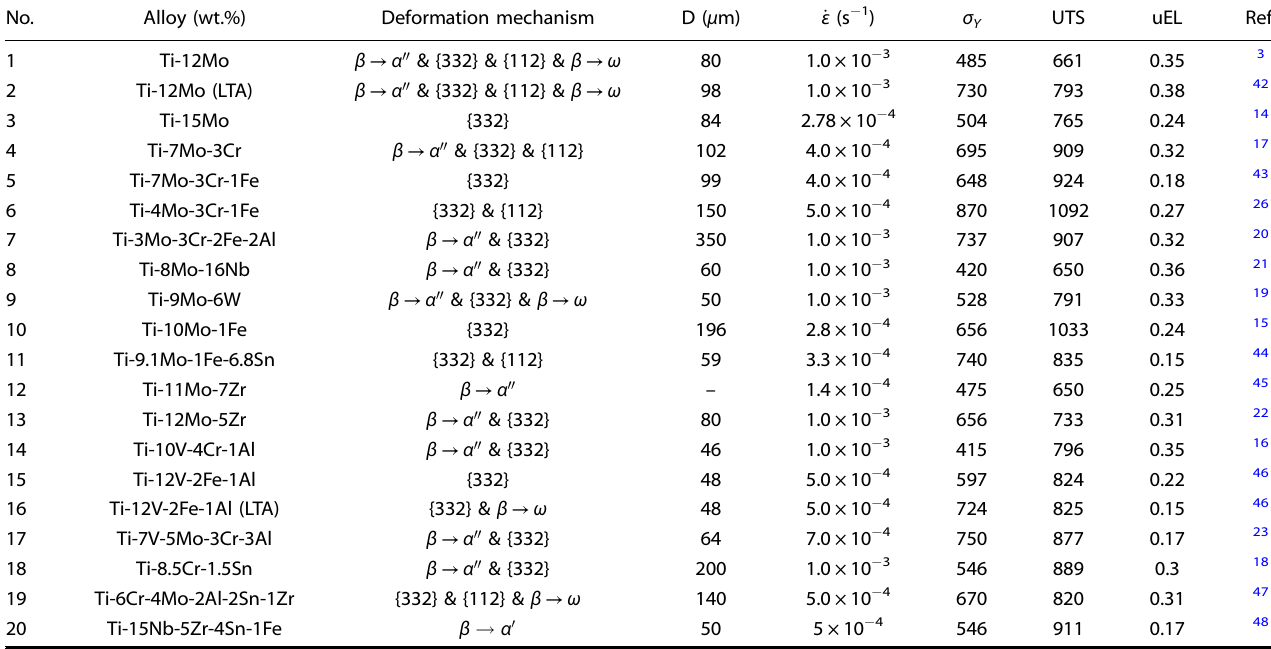
Table 1. Major TRIP/TWIP alloys with their operative deformation mechanism, grain size ( D , μ m), initial strain rate ( _ ε , s − 1 ) and mechanical properties including yield stress ( σ Y , MPa), engineering ultimate tensile stress (UTS, MPa) and uniform elongation (uEL) at the onset of necking. No. Alloy (wt.%)